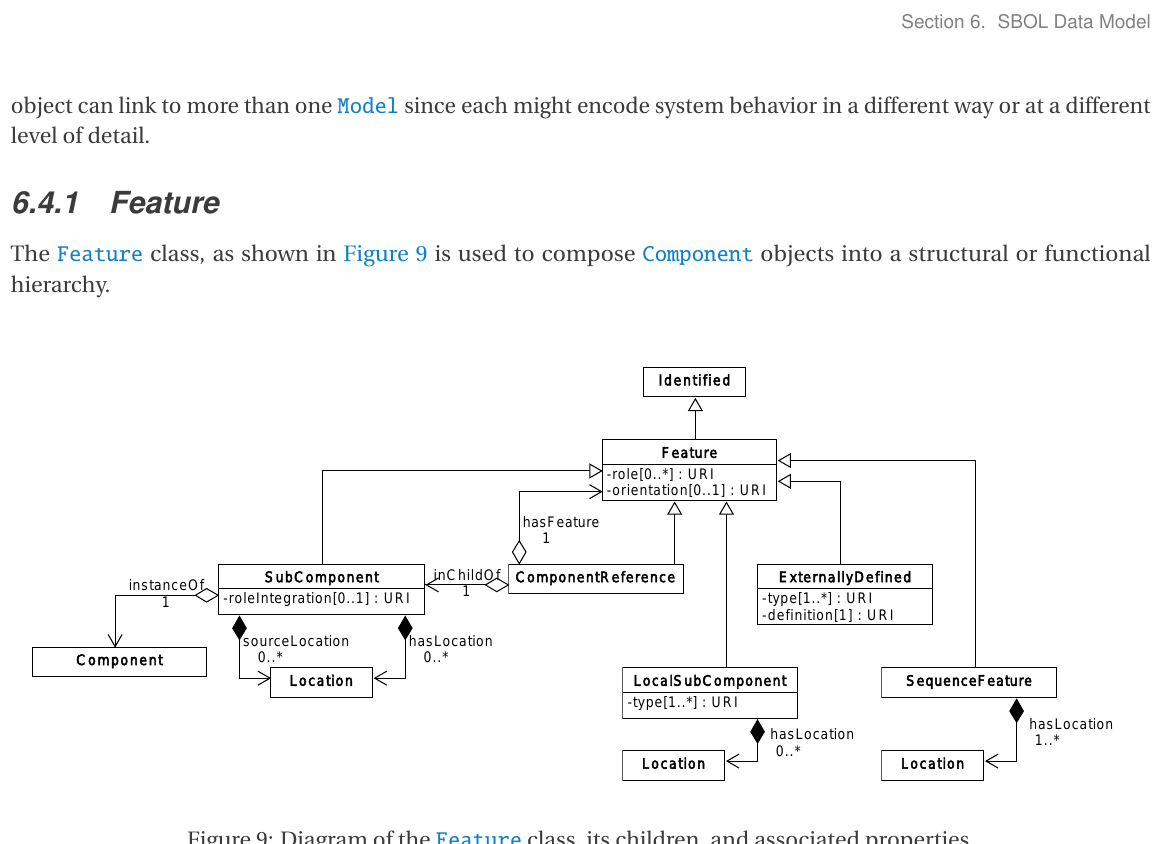
Figure 9: Diagram of the Feature class, its children, and associated